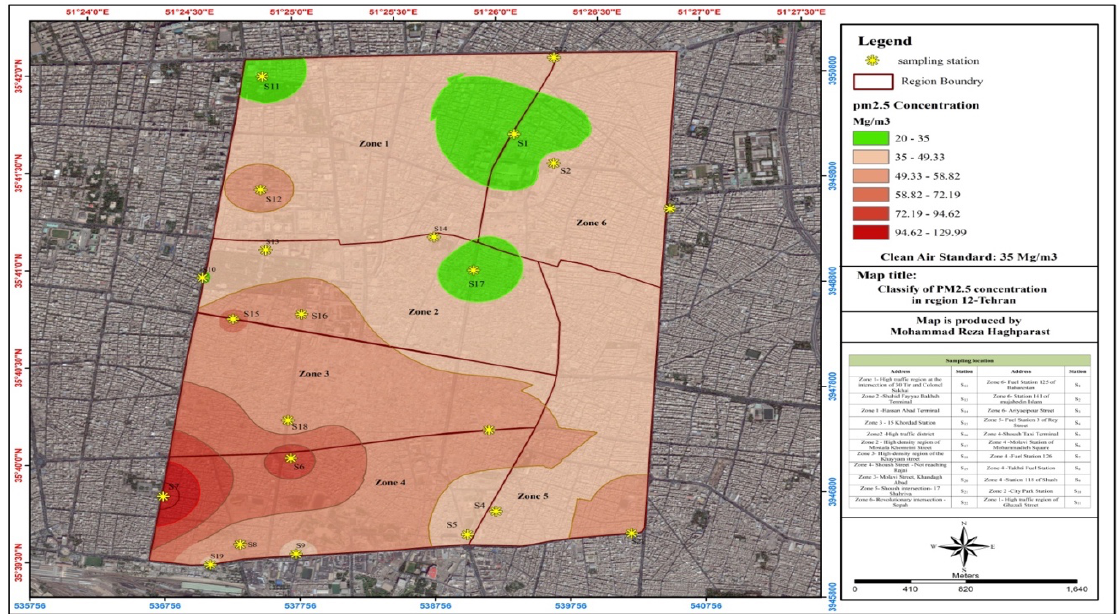
Figure 7. Zoning PM concentrations in the region on January, 2.5